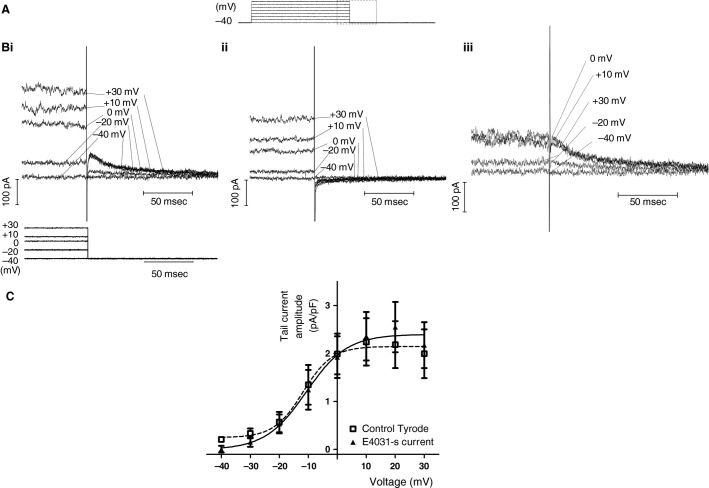
E-4031-sensitive IKr. (A) Schematic representation of square pulse protocol used (applied between −40 mV and +30 mV in 10 mV increments (start to start interval of 5 sec). The boxed area represents the corresponding portion of ionic currents displayed in (B), in order to optimise display of tail currents. (B) Selected currents at −40, −20, 0, +10 and +30 mV in normal Tyrode’s solution (Bi), in 5 μmol/L E-4031 (Bii) and as E-4031-sensitive current (Biii). Corresponding portion of voltage protocol is shown as lower traces in (Bi). Note that current axis in (Biii) differs slightly from that in (Bi) and (Bii). (C) I–V relations for tail currents obtained in control Tyrode solution (filled square, n = 8) and for E4031-s current (filled triangle, n = 8). Data for Type 1 and 2 cells were pooled. The plots were fitted with equation 2 (Materials and Methods), to give V0.5 and k values in normal Tyrode of −11.8 ± 4.3 mV (V0.5) and 5 ± 3.9 mV; for E-4031-sensitive current, the corresponding values were −10.7 ± 4.7 mV (V0.5) and 7 ± 4.4 mV.